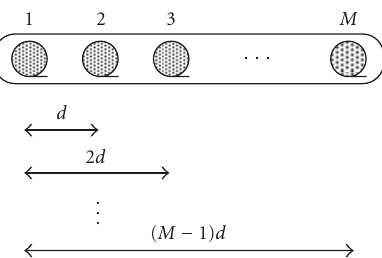
Figure 2: Uniform linear microphone array